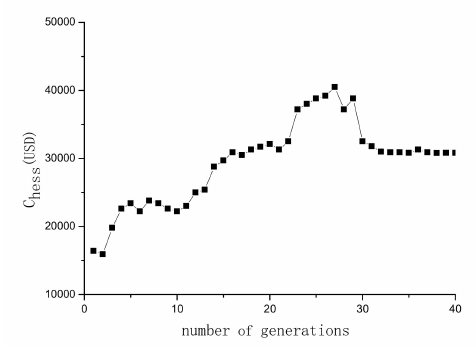
Figure 9. C hess convergence process. The l convergence process is as in Figure 10, basically stable after near 30 generations.